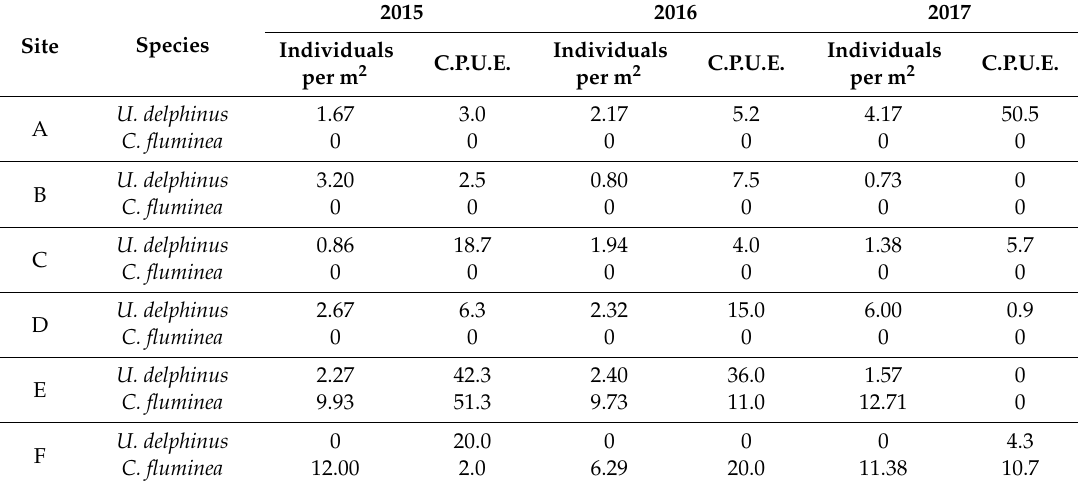
Table 2. Densities (individuals per m 2 ) and catch per unit of e ff ort (C.P.U.E., number of bivalves collected per researcher per hour) of U. delphinus and C. fluminea in six pool sites in the Oeiras river in three